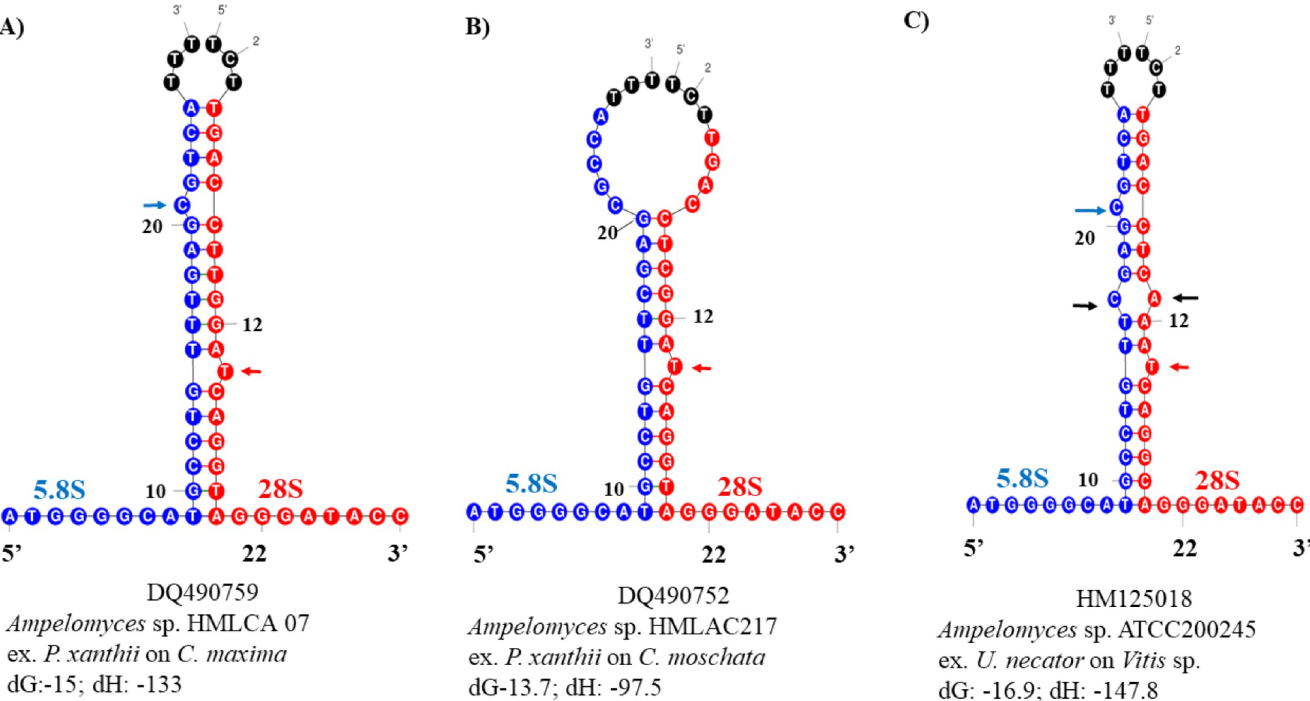
Fig 3. Two variations in the hybridization model of the proximal stem region were found in Ampelomyces . (A) The typical 5.8S and 28S hybridization model was obtained from an ITS2 sequence extracted from Ampelomyces conidia infecting P . xanthii . (B) A variation in the 5.8S and 28S hybridization model detected in Ampelomyces sp. infecting P . xanthii . (C) Another variation in the 5.8S and 28S hybridization model obtained from Ampelomyces sp. infecting E . necator (Section Uncinula ) chasmothecia. The blue nucleotides denote the 5.8S strand, the red nucleotides indicate the 28S strand and the black nucleotides comprise the flanking regions of the ITS2 spacer. The formation of an internal loop is indicated by the two black arrows. The typical free nucleotides found in the 5.8S and 28S strands are indicated with blue and red arrows, respectively. The GenBank accession number is shown below each structure. The Gibbs free energy (dG) and enthalpy (dH) values are shown after the taxon name.